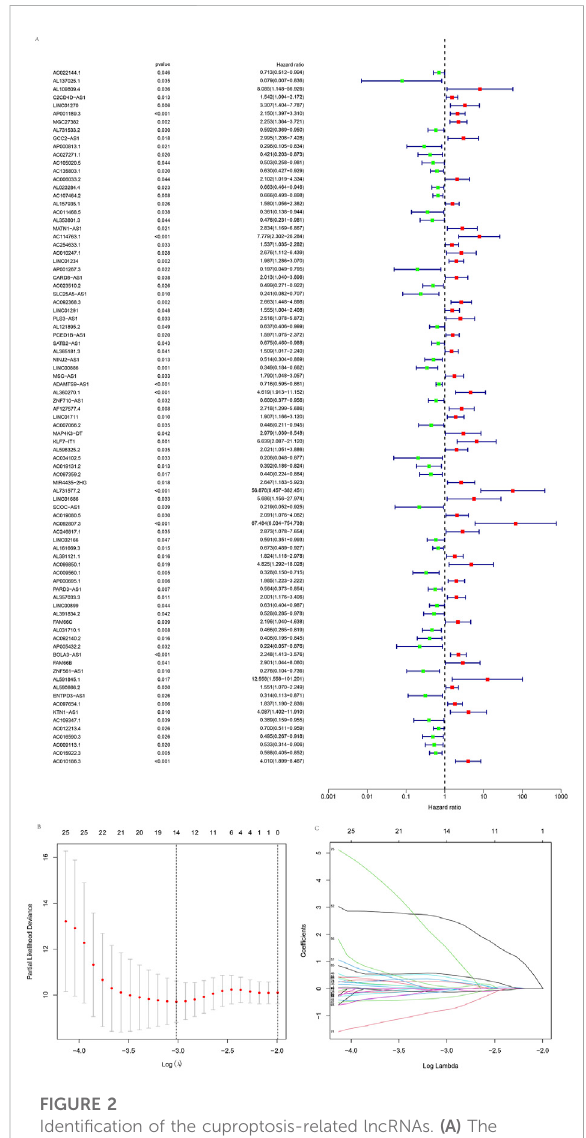
FIGURE 2 Identi fi cation of the cuproptosis-related lncRNAs. (A) The forestplotshoweddifferentlncRNAsforhighandlowrisk,withred representing high-risk lncRNAs and green representing low-risk lncRNAs. (B) Lasso regression screened cuproptosis-related lncRNAs at the minimum point of cross-validation. (C) The trajectory of each independent